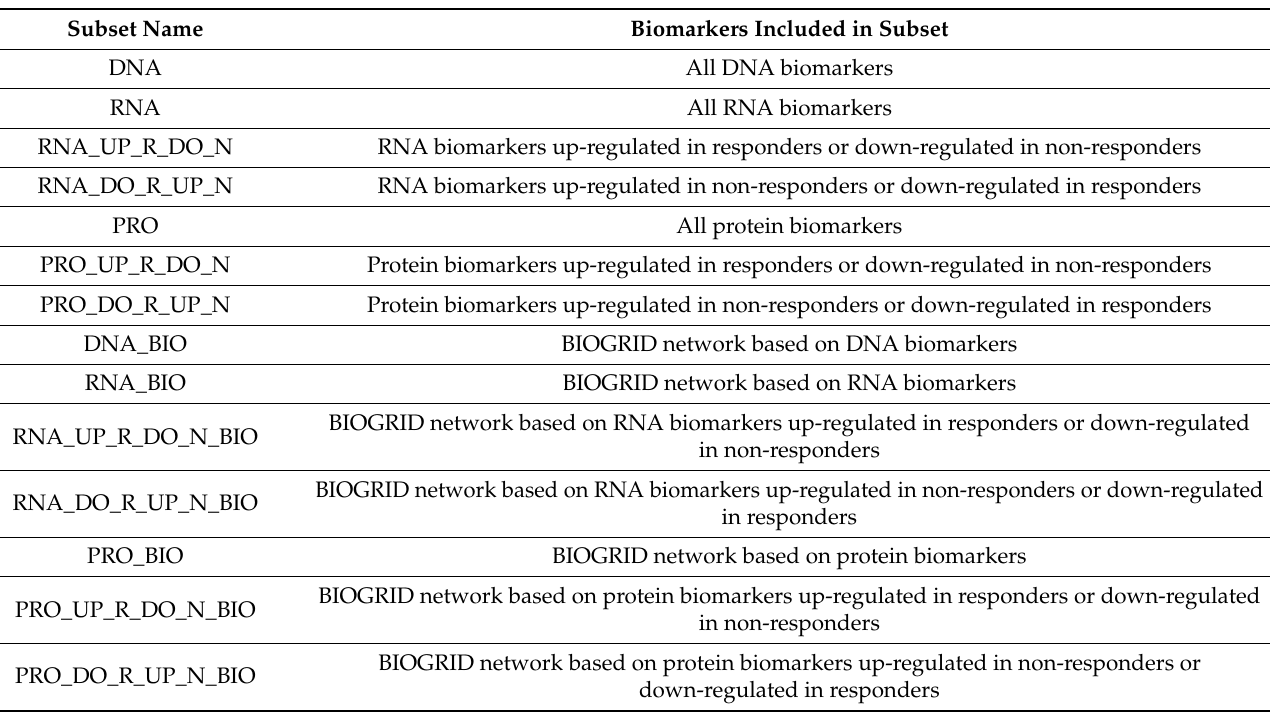
Table 1. Biomarker subsets. Subset names are constructed using biomarker type (DNA, RNA or PRO for protein) followed by association type (_UP_R_DO_N or _DO_R_UP_N) and indicate whether or not a given subset is a gene network derived from BIOGRID data